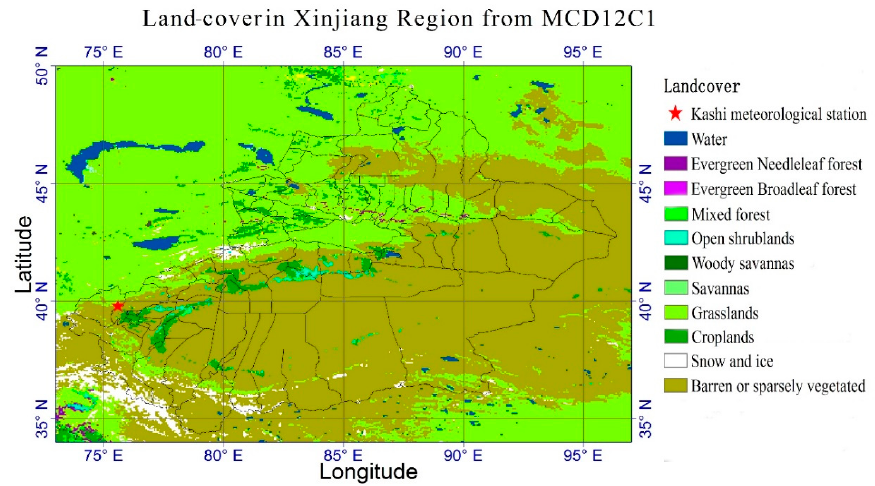
Figure 1. Land-cover in Xinjiang Region (from MODIS land cover product,